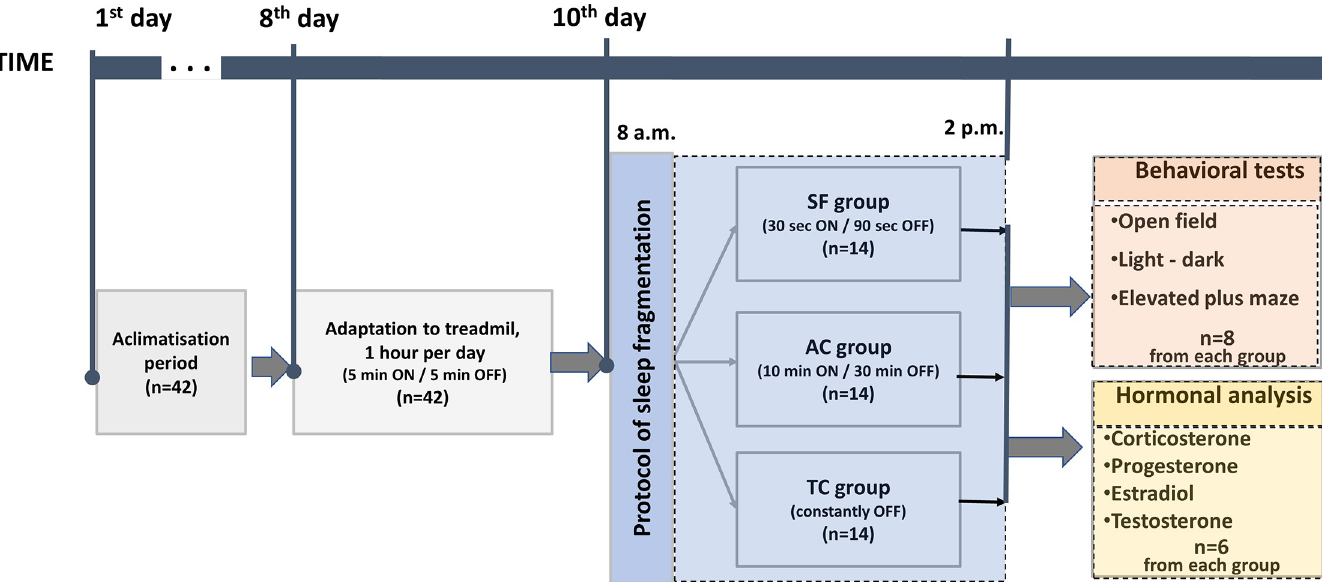
Fig 1. Schematic illustration of experimental design time flow. Animals (n = 42) were acclimatized to the laboratory conditions (7 days). Adaptation to the treadmill was performed in sessions of 1h (5 min ON and 5 min OFF working regime, treadmill belt speed ON = 0.02 m/s, OFF = 0m/s) during the next 3 days. Afterwards, the sleep fragmentation protocol has been applied and animals were divided into three groups (n = 14 in each group) and subjected to one of the three protocols in the treadmill during 6h of the light period: 1) sleep fragmentation (30s OFF: 90 s ON regime, 30 sleep interruptions per hour, SF group), 2) activity control group (10min ON: 30 min OFF regime, 1.5 sleep interruptions per hour, AC group), 3) treadmill control group (constantly OFF regime, 0 sleep interruptions per hour, TC group). Upon completion of sleep fragmentation protocols one cohort of animals (n = 8 from each group) has been subjected to in vivo ethological test of anxiety-like behavior (open filed, light—dart and elevated plus maze test), while another cohort of animals (n = 6 from each group) was sacrificed for blood sampling and further in vitro ELISA determination of hormonal levels (testosterone, progesterone, estradiol, corticosterone). For further details see the Materials and Methods section.